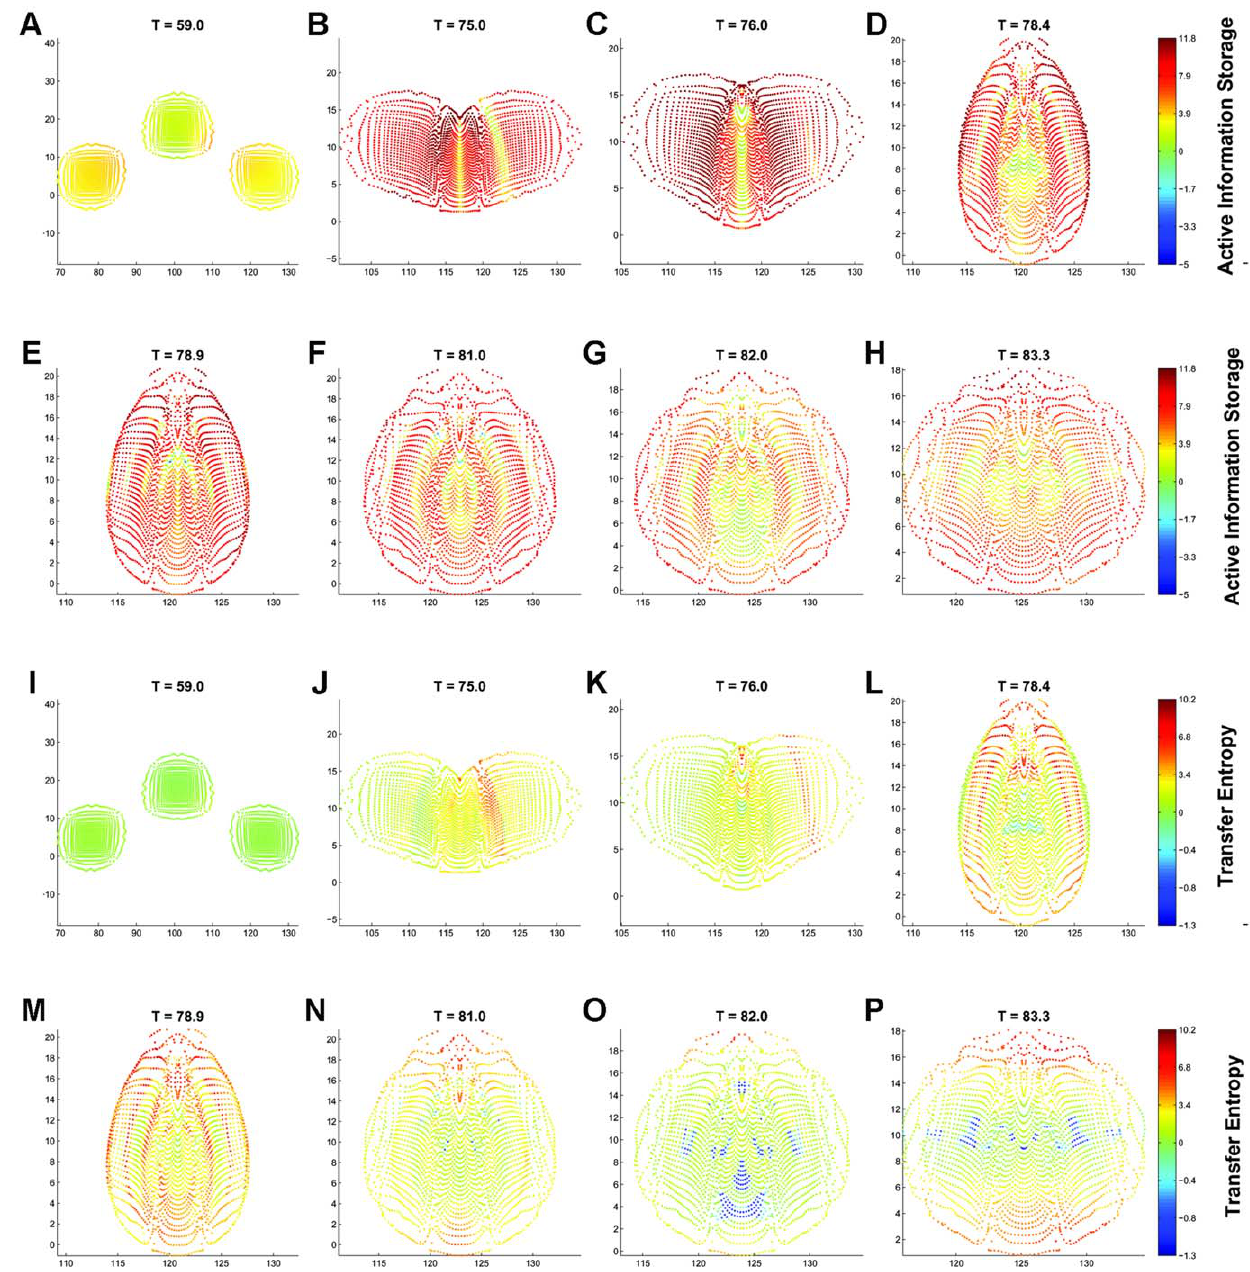
Figure 4. Local average information dynamics in a swarm at key time steps. A-H, active information storage, I-P, transfer entropy. The swarm initially consists of three squares in a checker configuration. The individuals’ two-dimensional positions are plotted on the x and y axes, and their colours represent the AIS and TE values in bits, as shown by the scale on the colour bar. Note that the axes scales are adjusted, and the colours are scaled differently for positive and negative